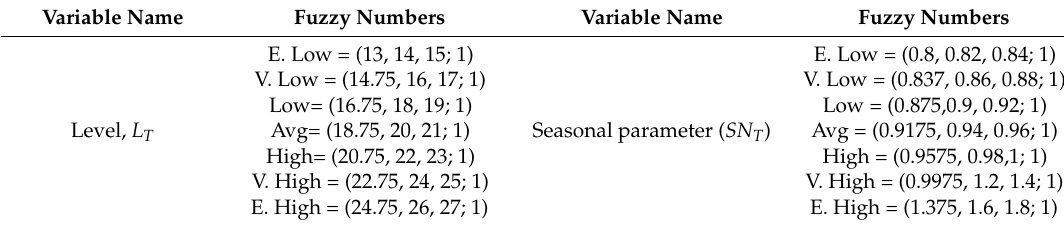
Table 3. Fuzzy numbers for the input and output